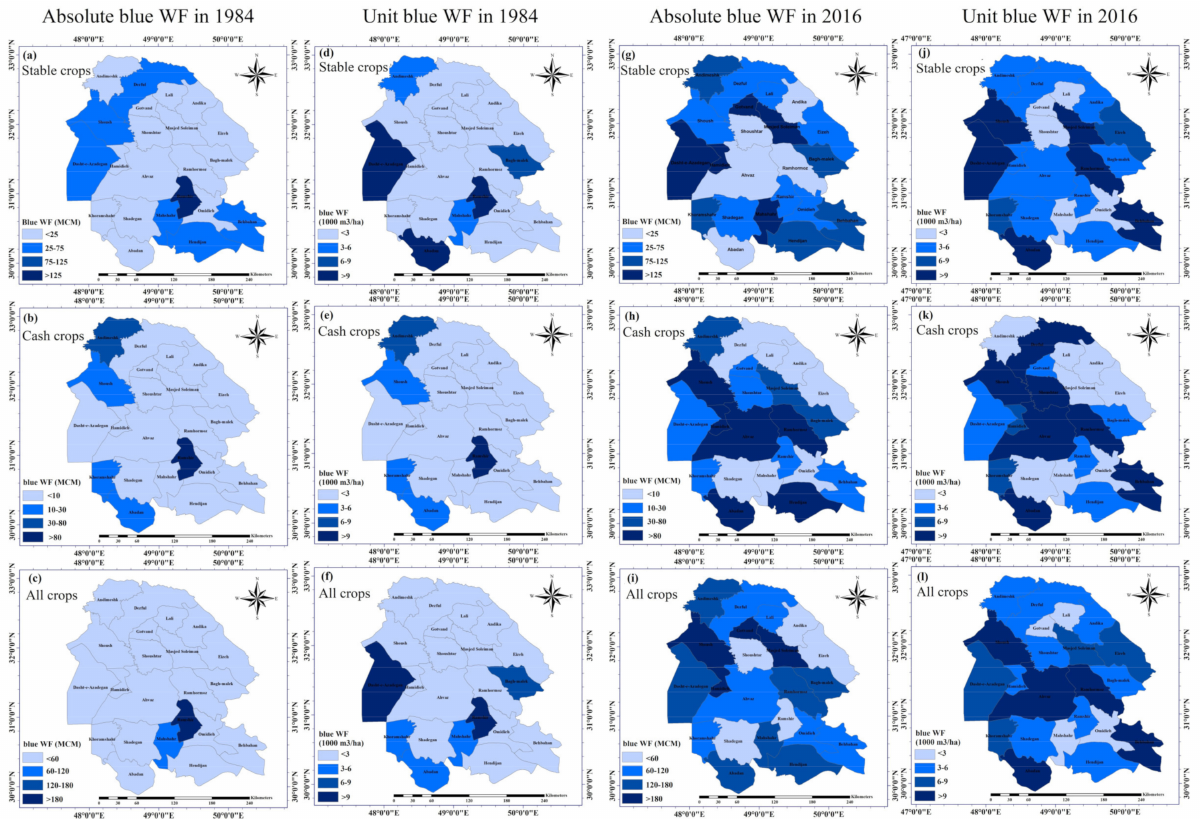
Figure 7. Spatial variation of total (m 3 y − 1 ) ( a – c , g – i ) and unit (10 3 m 3 ha − 1 ) ( d – f , j – l ) blue WF